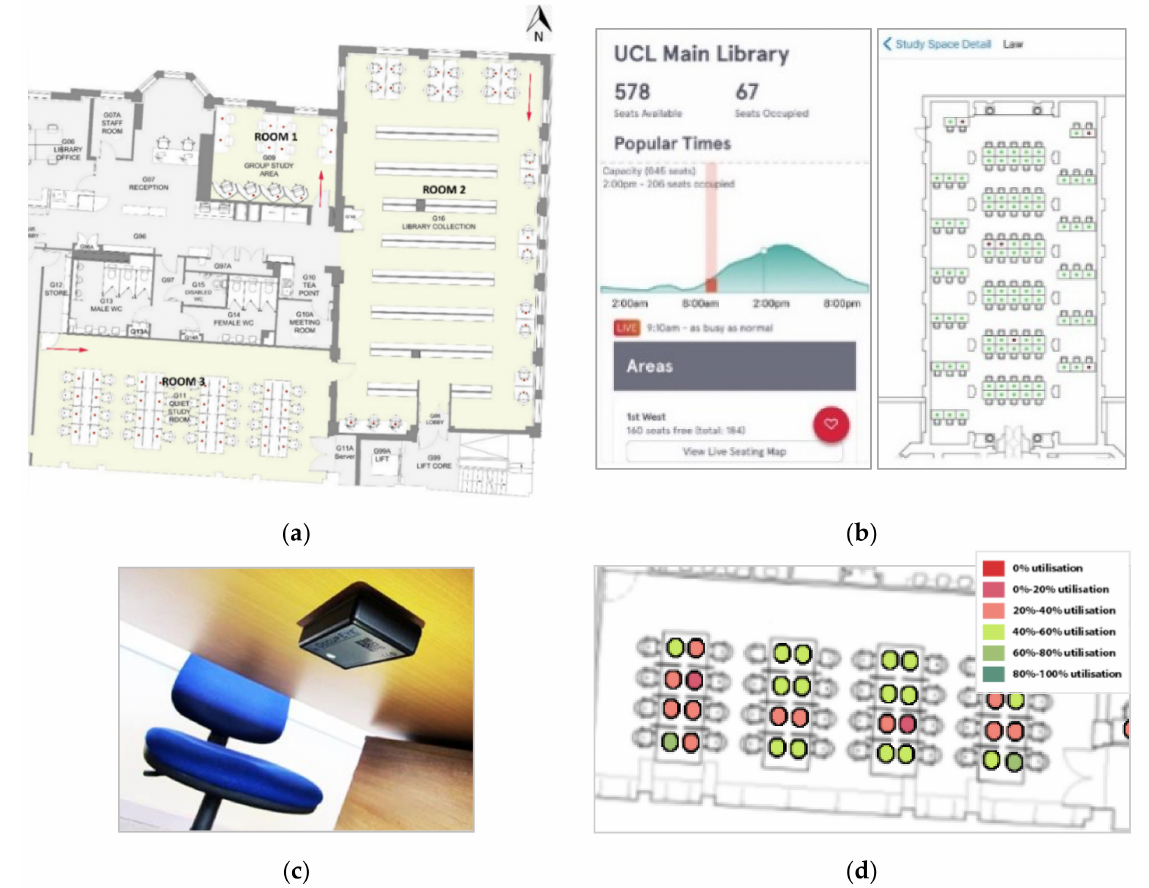
Figure 1. ( a ) Plan of the UCL Bartlett Library ( b ) Space availability information obtained from the UCL Go! Application ( c ) PIR sensors and ( d ) representation of occupancy at each seat in Occupeye